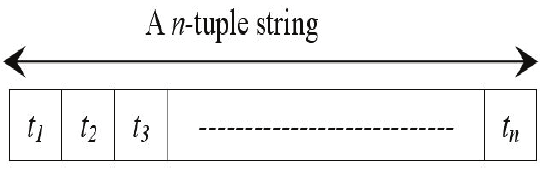
Fig. 1. An instance of project